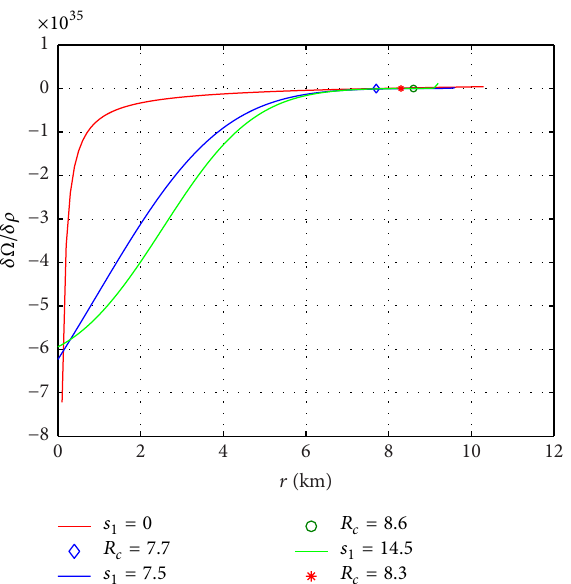
Figure 4: Cracking of PSR J1614-2230 with 𝛾 = 0.158 , 𝛼 = 0.24 , and = 0, 7.5, 14.5 . 𝑠 1